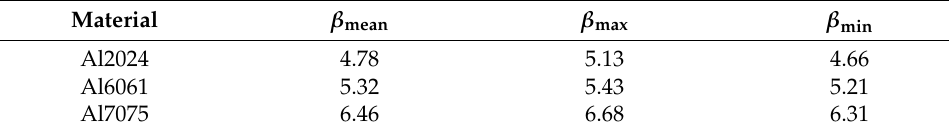
Table 4. Measurement results of the absolute nonlinear parameter β .